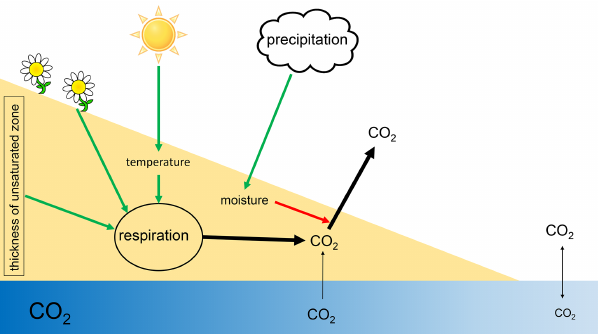
Figure 9. Scheme of processes and drivers of CO 2 fluxes from dry river sediments. Green arrows indicate positive effects; red arrows indicate negative